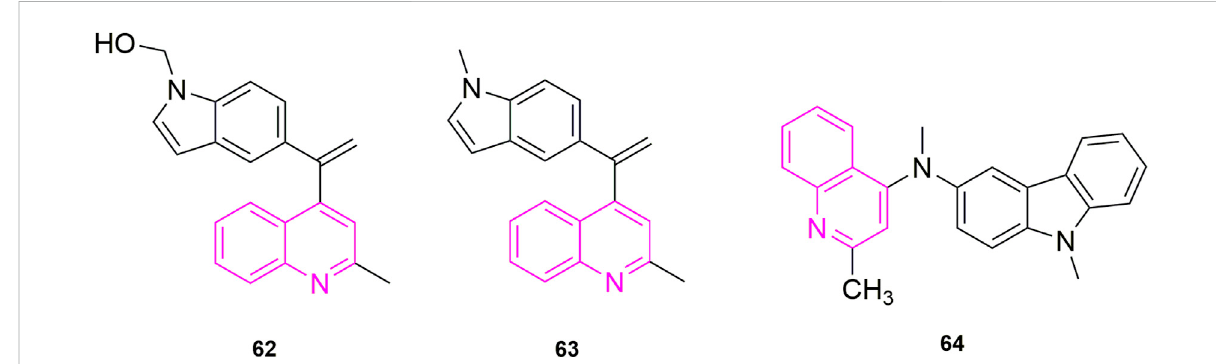
The structures of the compounds designed by Li et al. (2019) and Kheli fi et al.